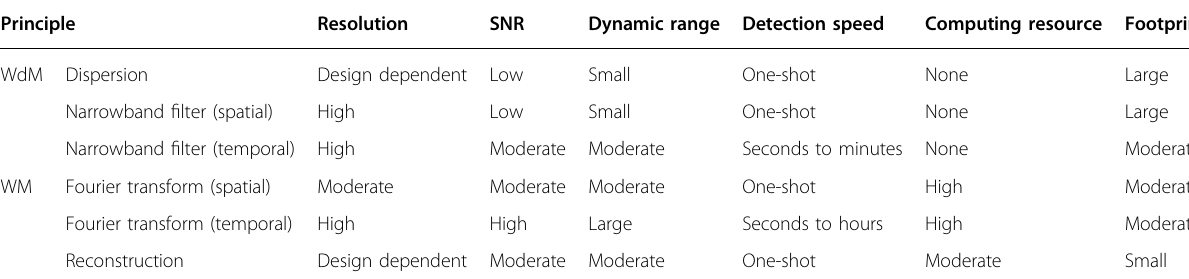
Table 2 The general characteristics of different spectrometer schemes Principle